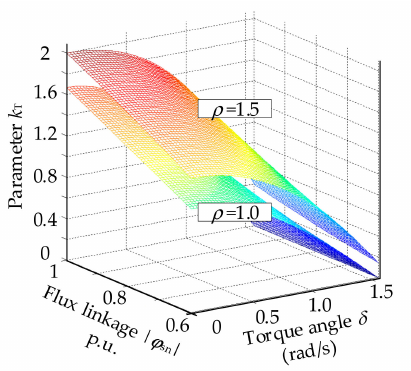
Figure 3. The relationship of the torque change rate k T with the flux amplitude and load